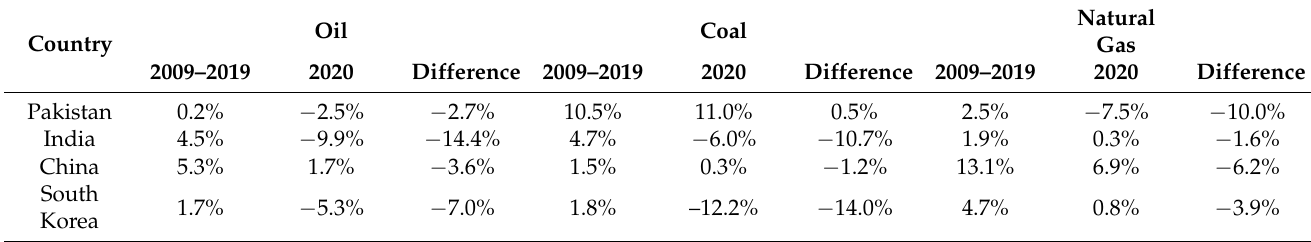
Table 4. Percentage consumption of oil, coal, and natural gas each year during 2009–2019 and in 2020, as well as the